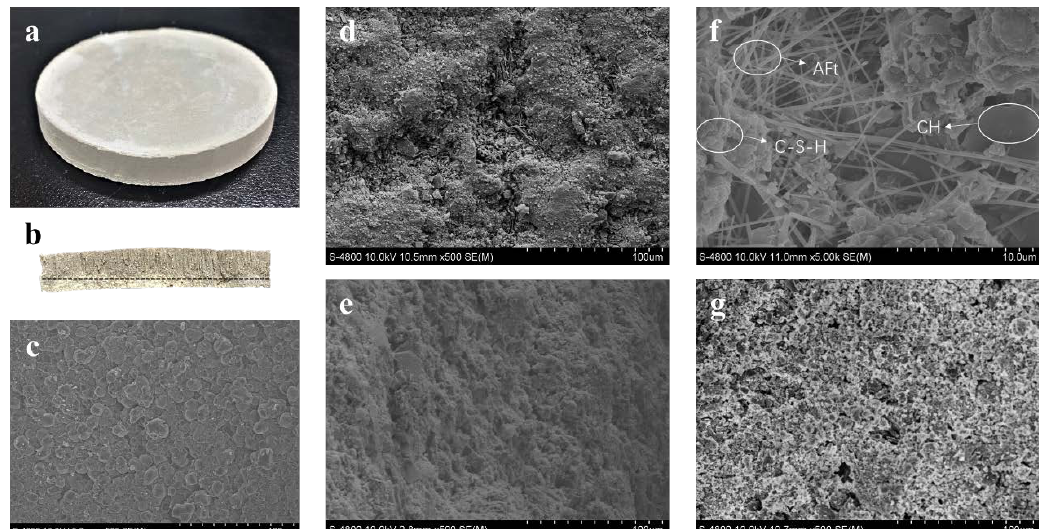
Figure 4. SEM images of the PSCM under the conditions of 50 wt. % and temperature of 100 ° C based on the hot–dry casting process: ( a ) the overall morphological structure, ( b ) the cross section, ( c ) the bottom surface, ( d ) the cross-section of the separation layer, ( e ) the vertical cross section and ( f ) its details, and ( g ) the upper surface.